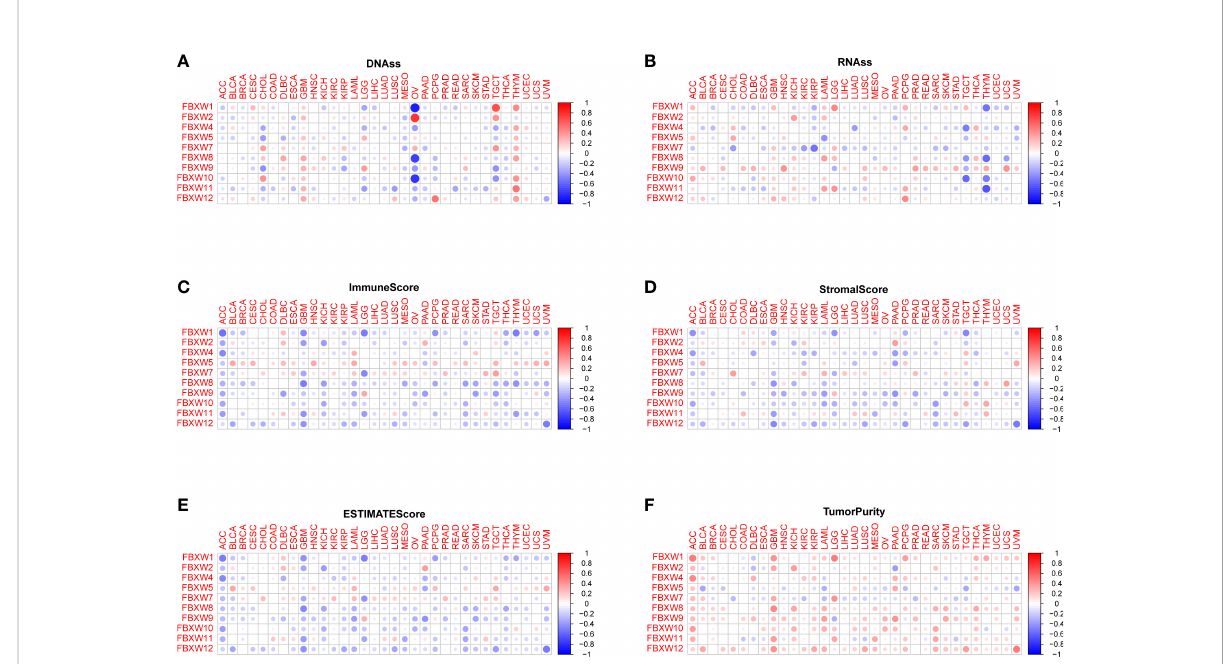
FIGURE 9 Association between FBXW family gene expression and tumor micro-environment factors and stemness score in pan-cancer. The FBXW family gene associated immune score (A) , stromal score (B) , estimate score (C) , DNAss (D) , RNAss (E) and tumor purity (F) are